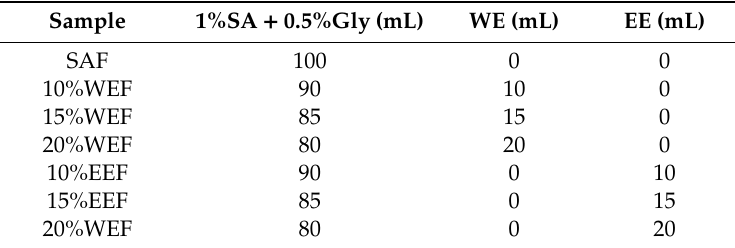
Table 1. The formulations of the